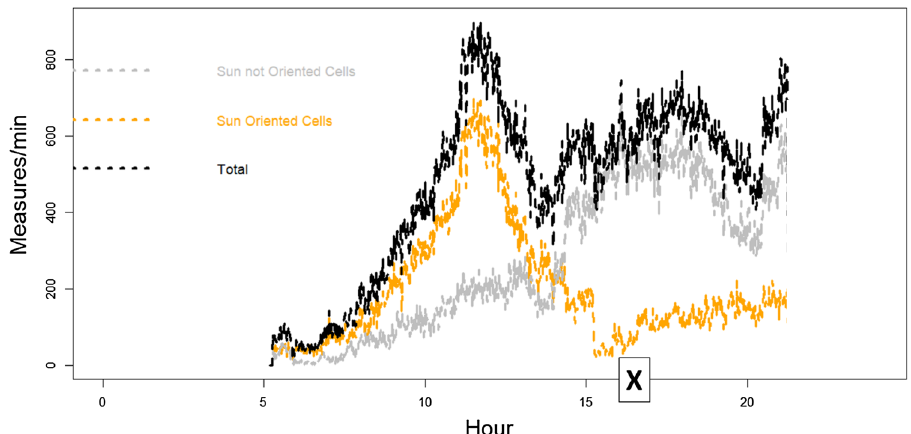
Figure 12. Example (Ferrara and Ravenna area) of the total number of connections (in black) during sunlight hours on the 3rd of July. The grey line identifies the part of the connection related to non-Sun-exposed BS cells, whereas the orange line identifies the part of the connection related to Sun-exposed BS cells. Trends are unbalanced. “X” indicates the flare peak in X-ray emission (local Italian time, UT + 2H).